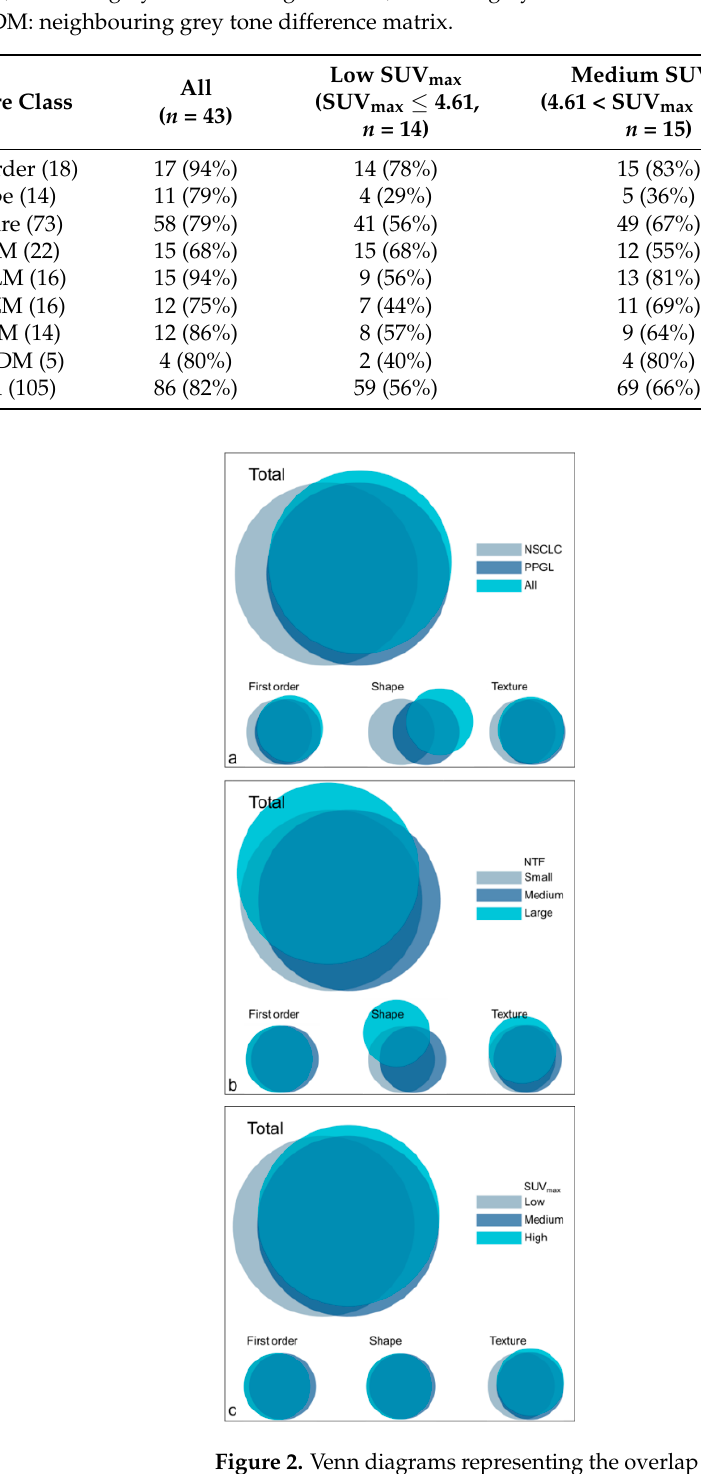
Figure 2. Venn diagrams representing the overlap in affected features per feature class for the cohorts ( a ) and subgroups (( b ): NTF, ( c ): SUV max ). NSCLC: non-small cell lung carcinoma, PPGL: pheochromocytoma and paraganglioma, NTF: necrotic tumour fraction, SUV max : maximum standardised uptake value.